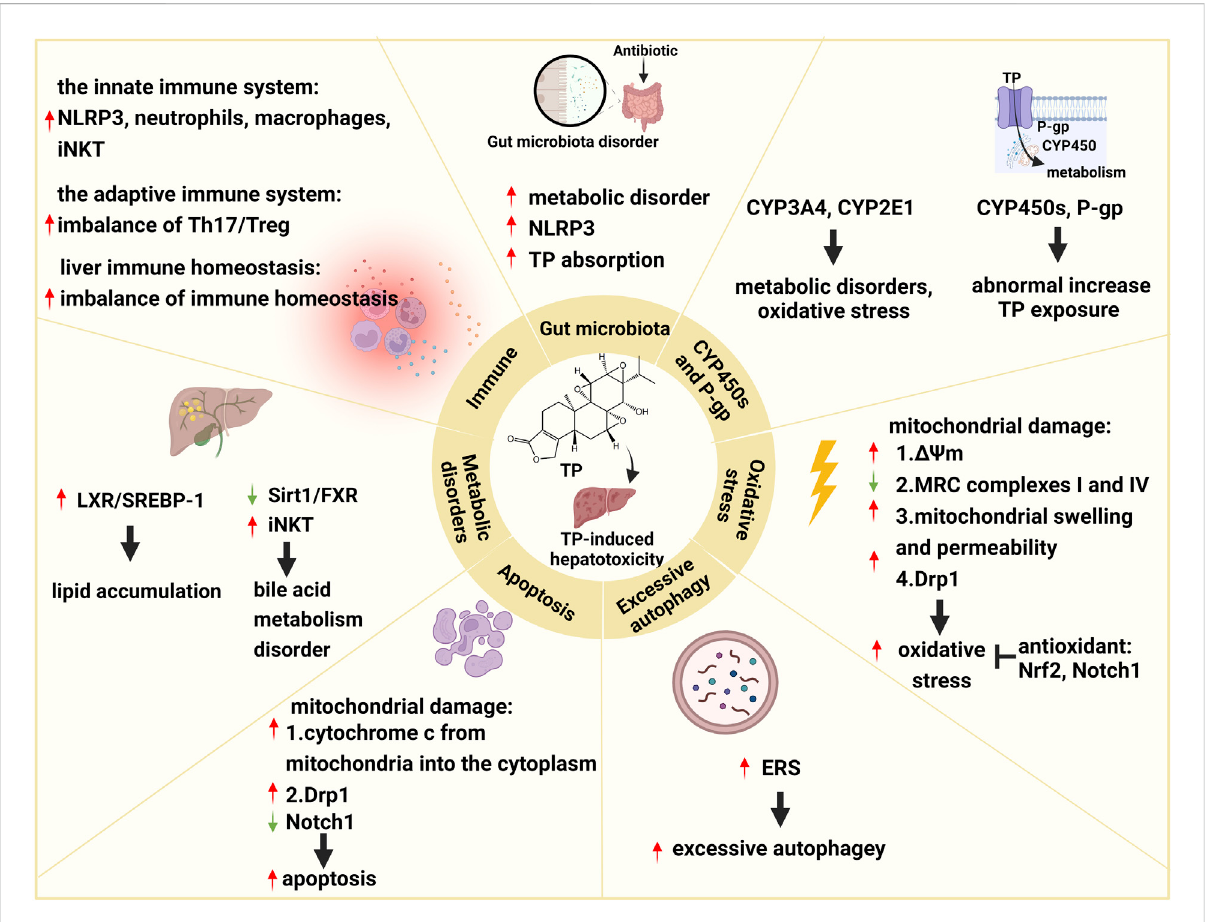
FIGURE 1 SchematicdiagramofmolecularpathogenesisofTP-inducedhepatotoxicity.This fi gureshowsthatTP-inducedhepatotoxicityismainlyrelated to CYP450s, P-gp, oxidative stress, excessive autophagy, apoptosis, metabolic disorders, immunity, and the gut microbiota. ↑ : upregulation; ↓ : downregulation; ┬ :